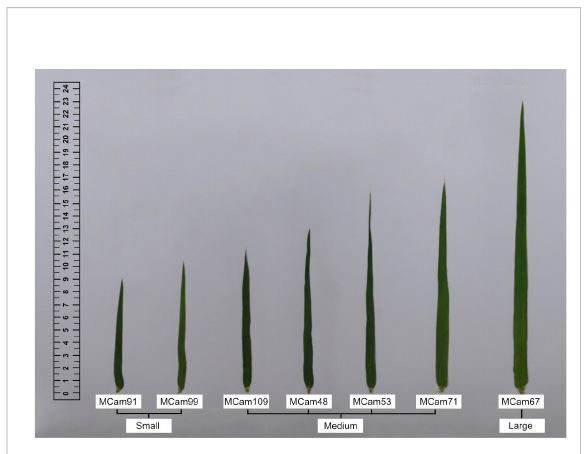
FIGURE 1 Flag leaves of seven barley accessions (RILs) classi fi ed into three groups according to fl ag leaf size: small, medium, and